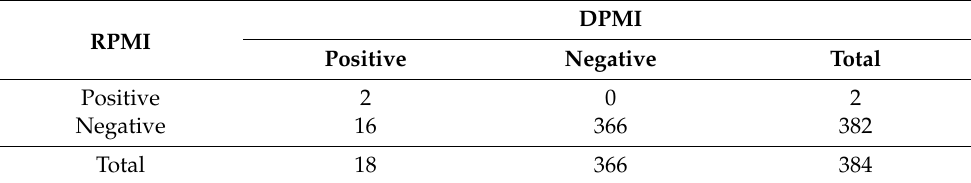
Table 2. Contingency table (2 × 2) to compare routine and detailed abattoir inspections.